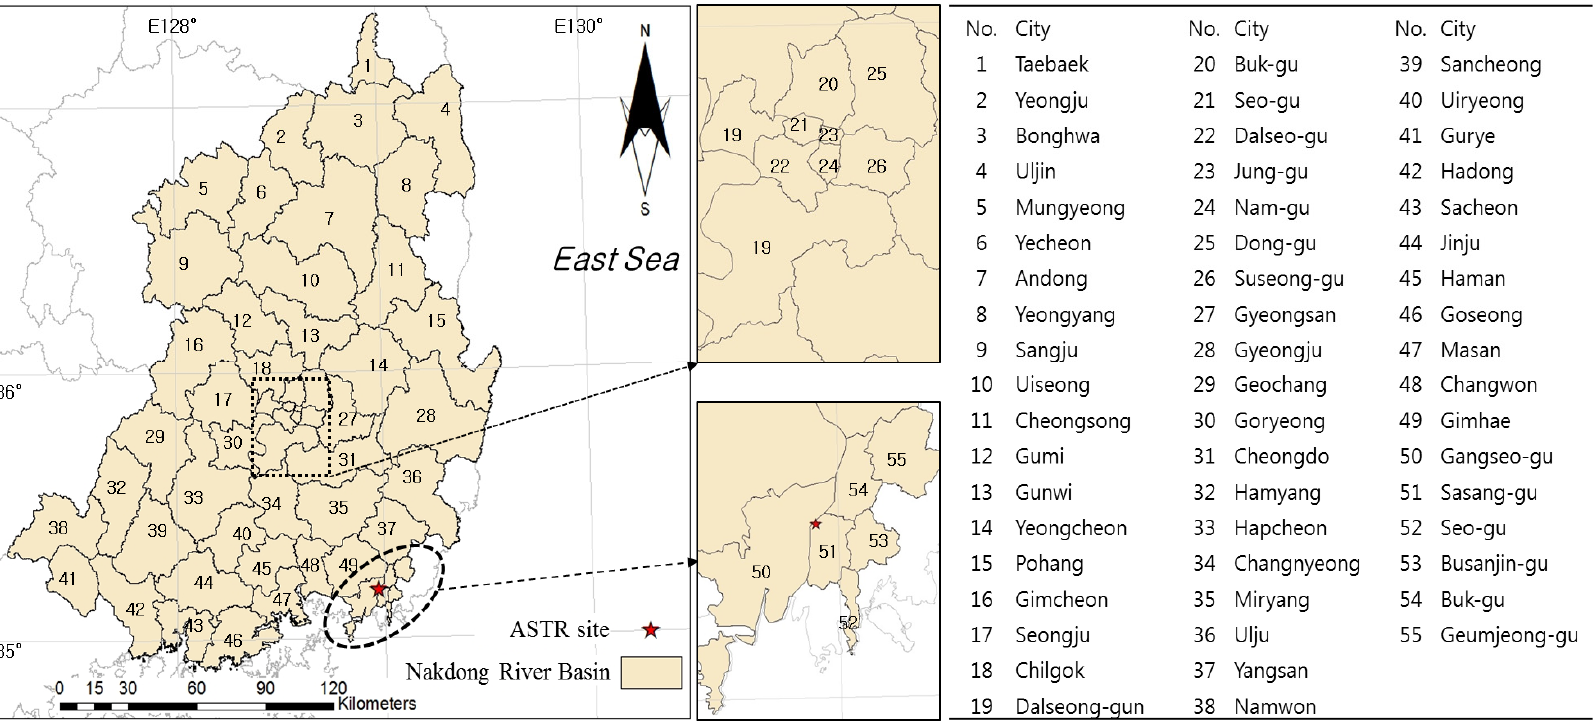
Figure 4. Cities in the Nakdong River Basin.